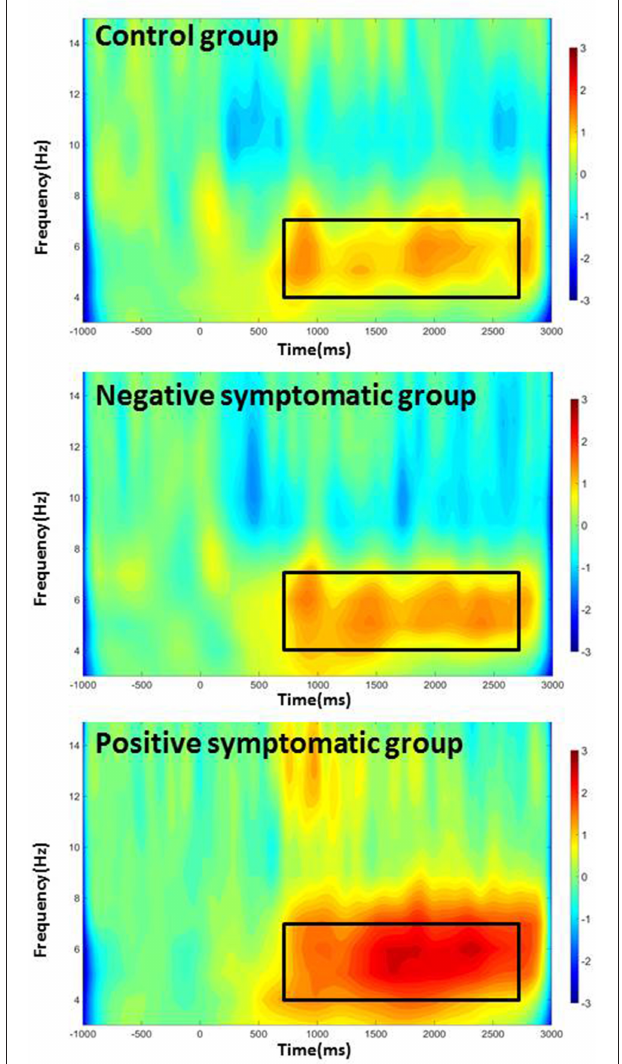
FIGURE 2 | Frontal theta band activity for the high-load manipulation condition for all three groups. The frequency of interest (4–7 Hz) and time period of interest (delay period) are indicated with a